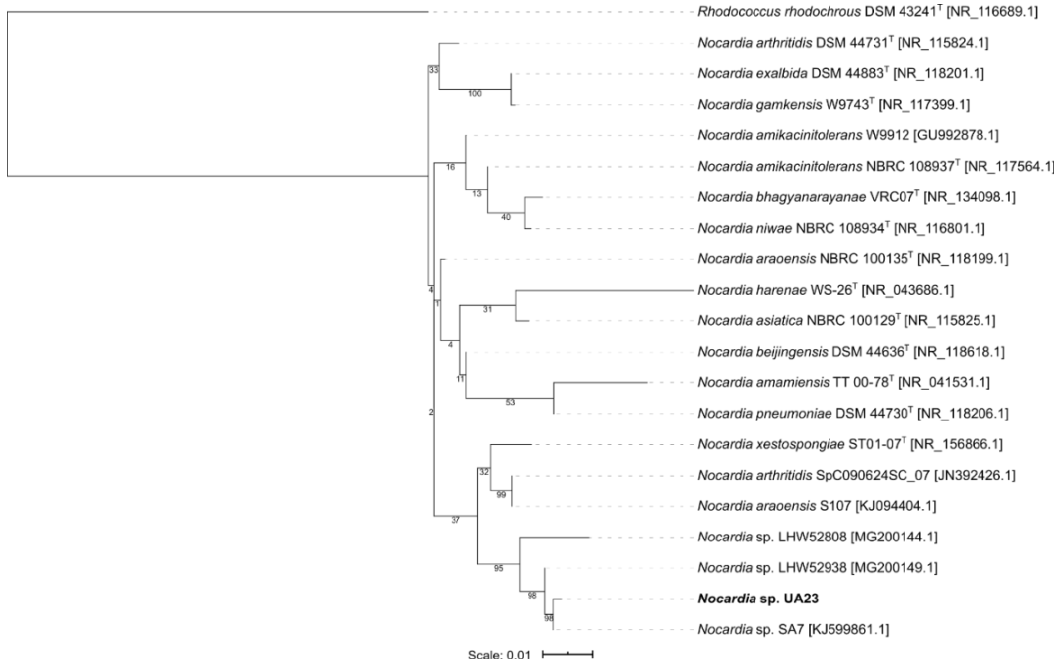
Figure 4. Maximum-likelihood tree of 20 Nocardia representatives and one Rhodococcus strain as an outgroup. Bootstrap values (100 resamples) are given in percent at the nodes of the tree. The isolate Nocardia sp. UA23 obtained in this study is presented in bold.